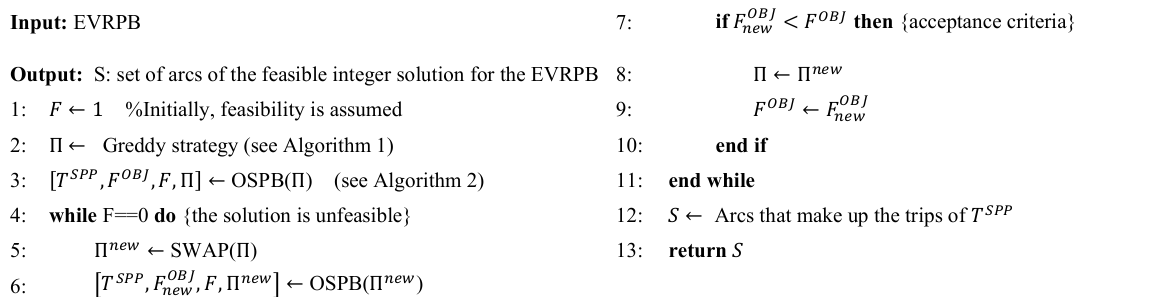
Algorithm 3. ILS pseudo